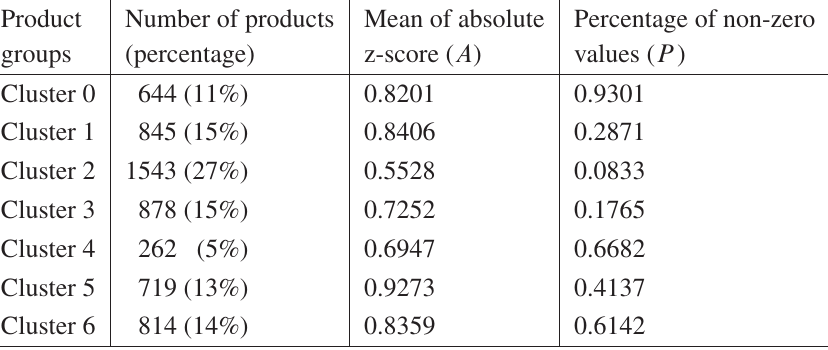
Table 10. Tier-1 monthly stability analysis with the EM algorithm in 2005.